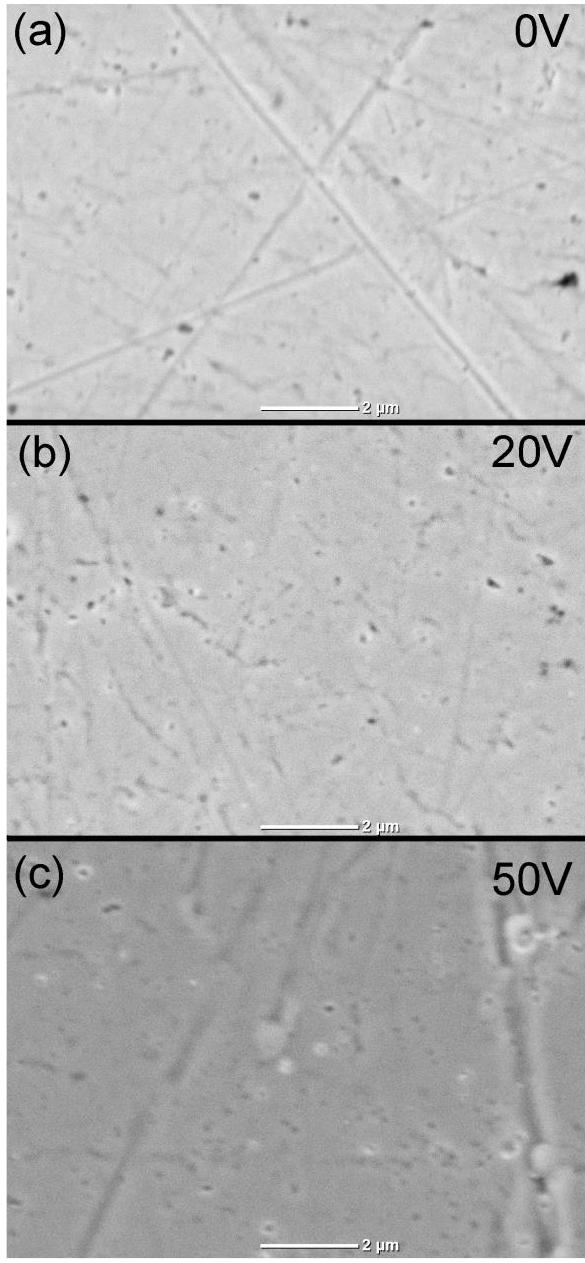
Figure 7. SEM image of the sample surface at ( a ) 0 V before anodization, ( b ) 20 V and ( c ) 50 V after anodization.